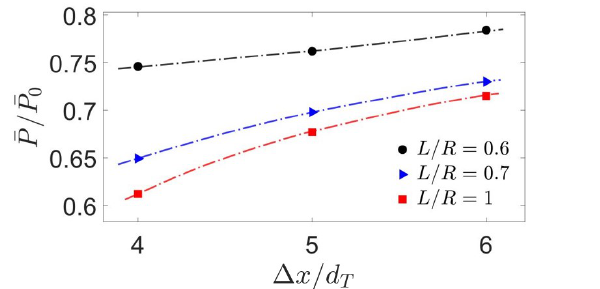
Figure 14. Mean power output ( P ) of a standard turbine ( L / R = 1) downwind of a truncated turbine located at the central row of a 2 × 3 wind farm. P 0 is the mean power of the isolated base